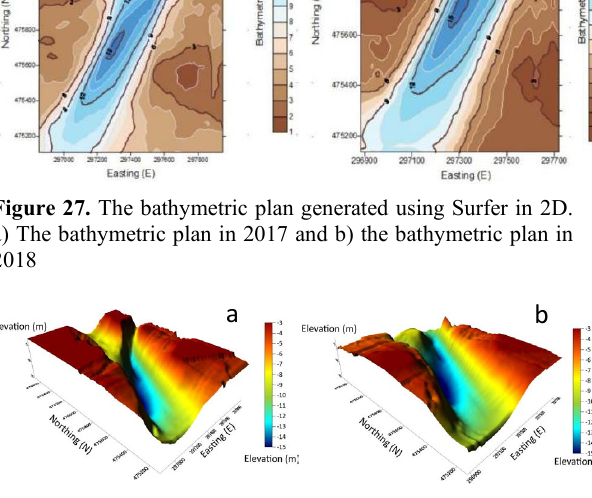
Figure 28. The bathymetric plan generated using Surfer in 3D. a) The bathymetric plan in 2017 and b) the bathymetric plan in 2018 The river floor of 2017 and 2018 bathymetric plan relative to DSMM tide gauge is identical to the bathymetric plan relative to the on-site tide gauge. The difference in river floor between the 2 years is also due to the same causes. The sedimentation that affects the bathymetric plan relative to the on-site tide gauge is in the same way that it affects the bathymetric plan relative to the DSMM tide gauge.